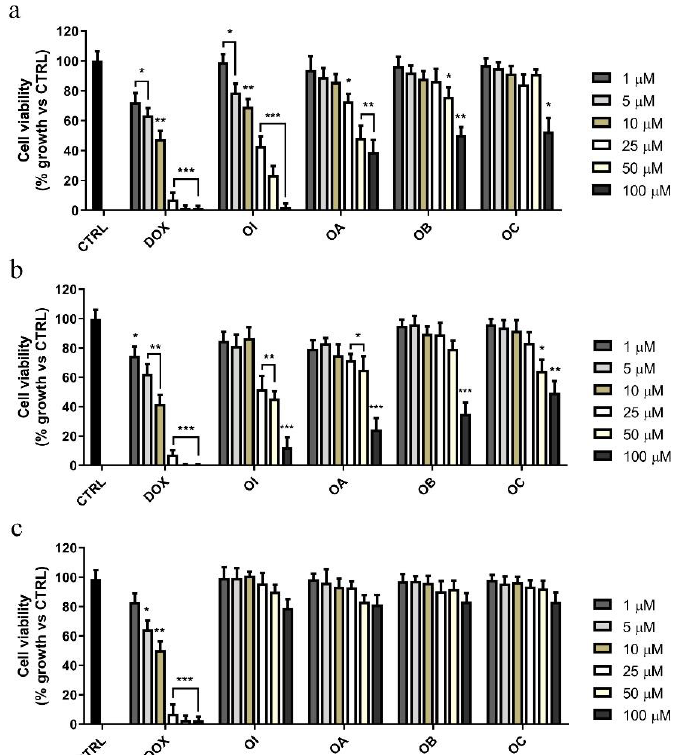
Figure 1. Effects of the compounds OA-OI on MCF-7, HeLa, and MCF-10A cell growth. ( a ) Breast cancer cells (MCF-7), ( b ) human uterine cervix adenocarcinoma cells (HeLa), and ( c ) non-tumorigenic breast epithelial cells (MCF-10A) were treated for 72 h with vehicle alone (control cells, CTRL) or increasing doses (1 to 100 µ M) of each compounds or doxorubicin (DOX), as indicated. Cell viability was assessed by MTT assay and was expressed as percentage of growth vs. CTRL. Values represent means ± SD of three different experiments, each performed with triplicate samples. * p value < 0.05; ** p value < 0.01; *** p value < 0.001.